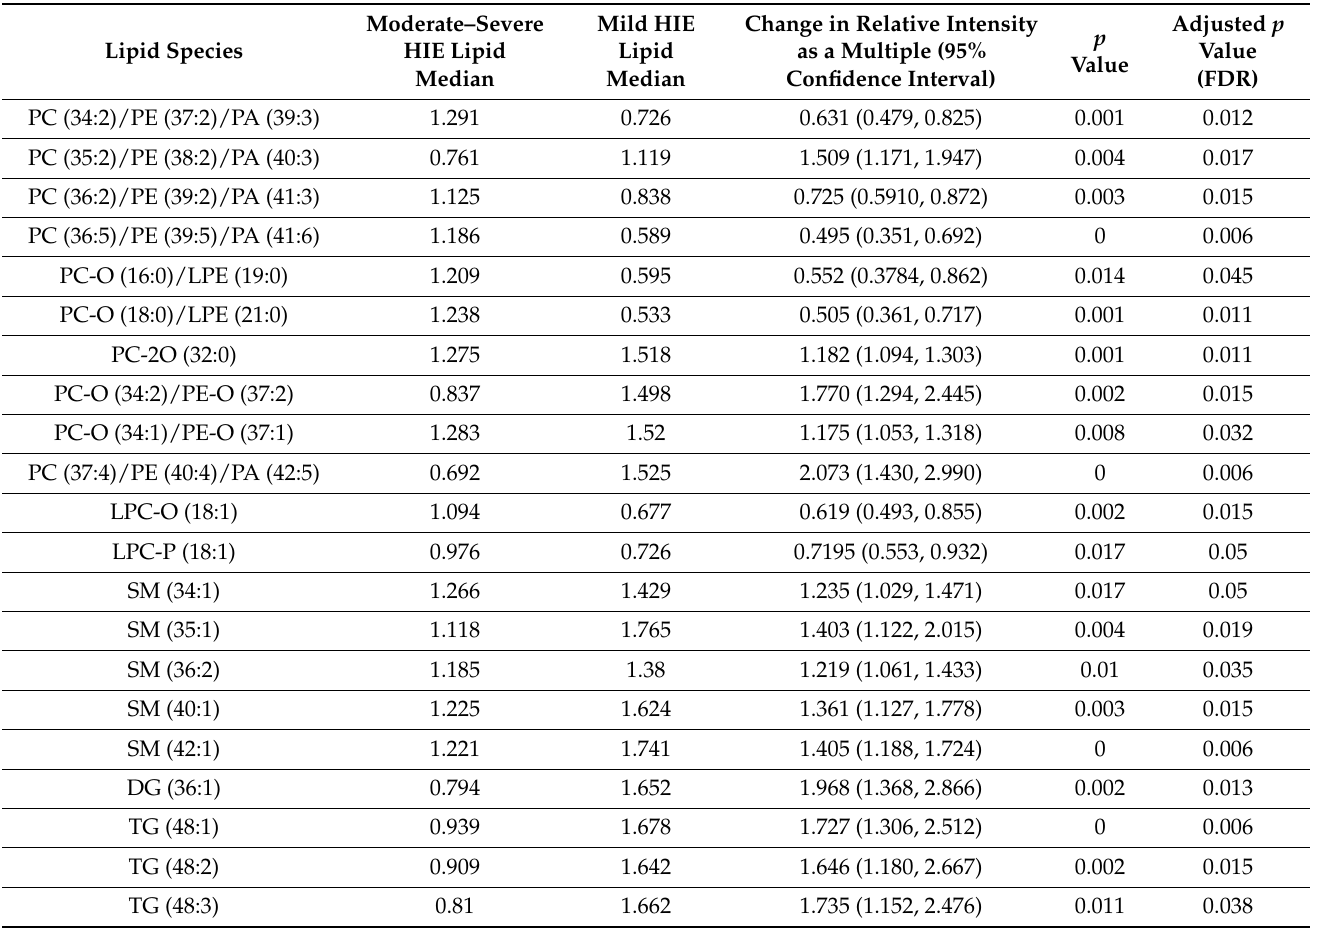
Table 3. Mann–Whitney U test statistics for the significant lipid species when comparing Moderate–severe HIE at S3 vs. Mild HIE.